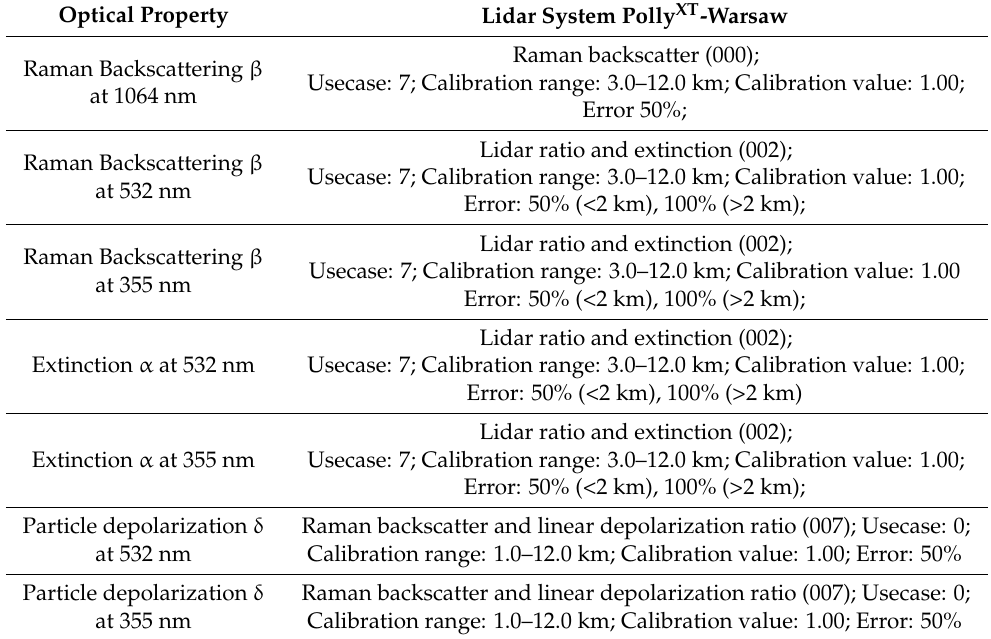
Table 1. SCC settings for Polly XT lidar system for particular optical products retrieval. Optical